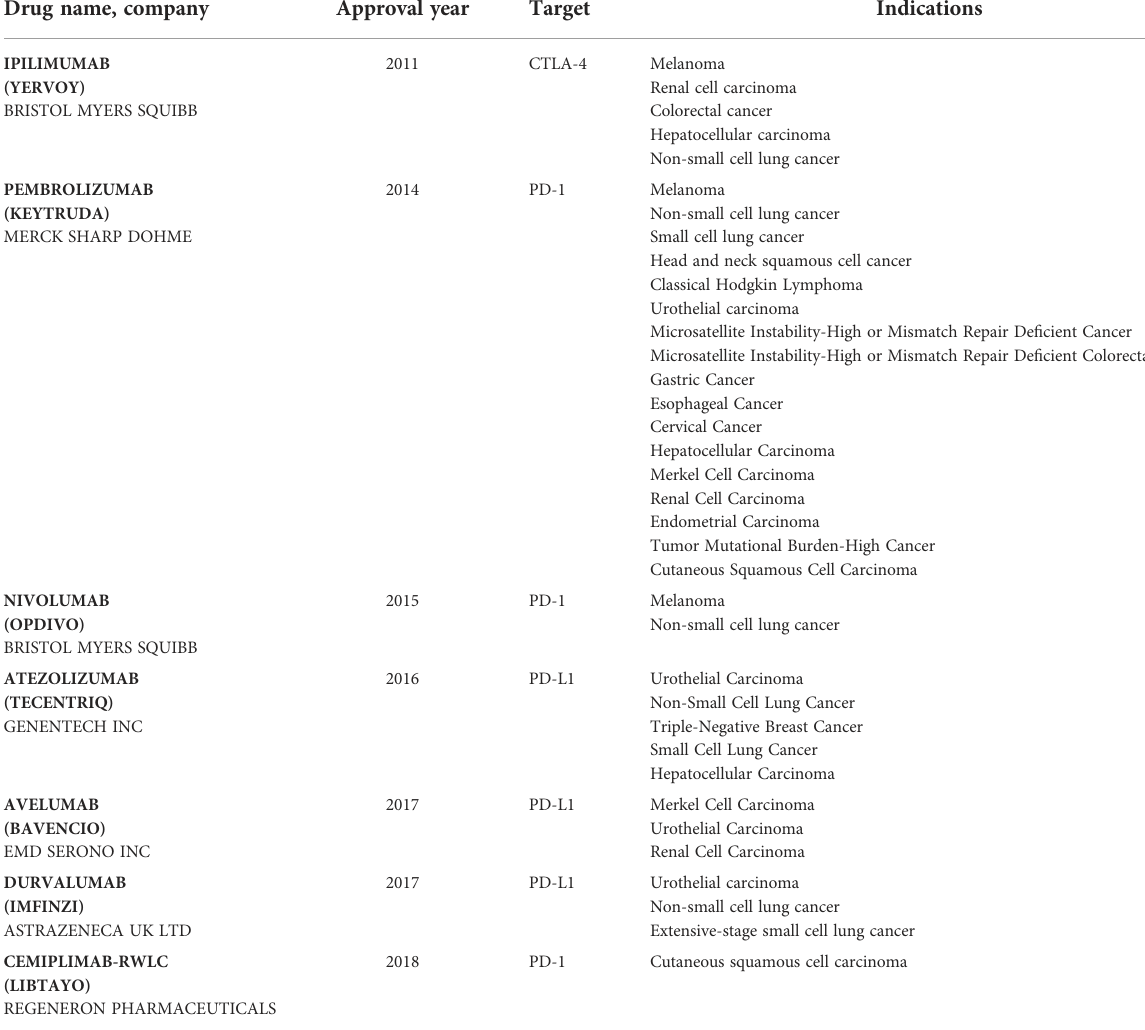
TABLE 1 Approved ICIs according to FDA labels. Drug name,